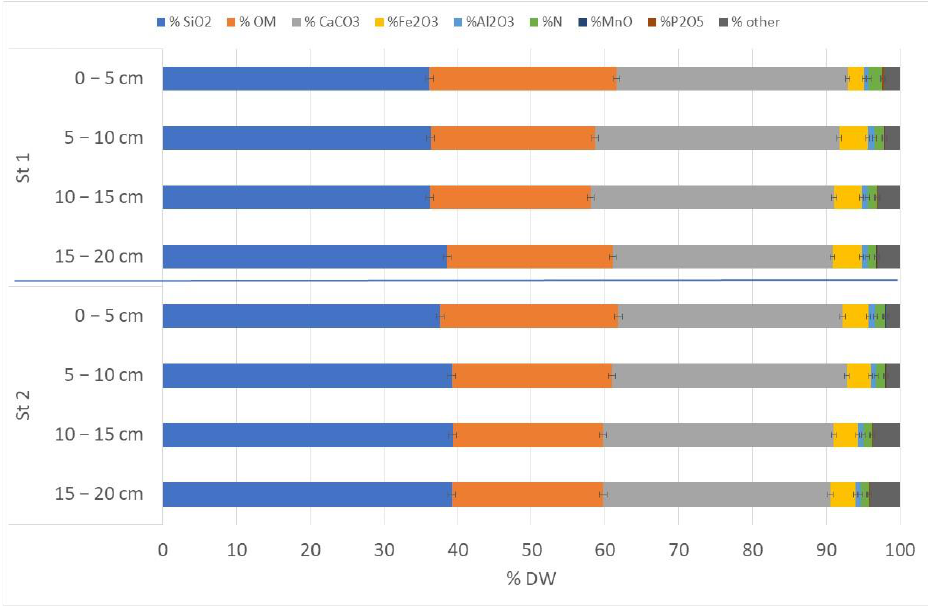
Figure 7. Amount of components in bottom deposits (±SD) of Lake Kortowskie (in